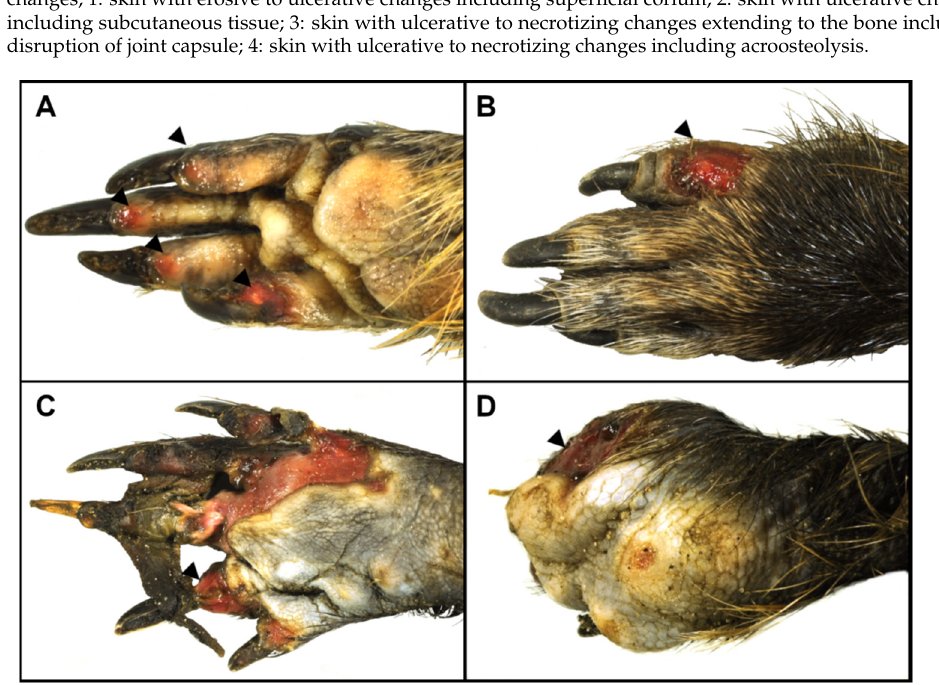
Figure 2. Skin lesions of the distal limbs in coypus ( Myocastor coypus ). Grade 1 skin lesion with erosive to ulcerative changes affecting the superficial corium of the toe pads (arrowheads; ( A )). Grade 2 skin lesion characterized by ulcerative changes of the skin and subcutaneous tissue (arrowhead; ( B )). Grade 3 skin lesion with ulcerative changes extending to the bone including disruption of joint capsules (arrowhead; ( C )). Grade 4 skin lesion with necrosis and acroosteolysis of phalanges (arrowhead; ( D